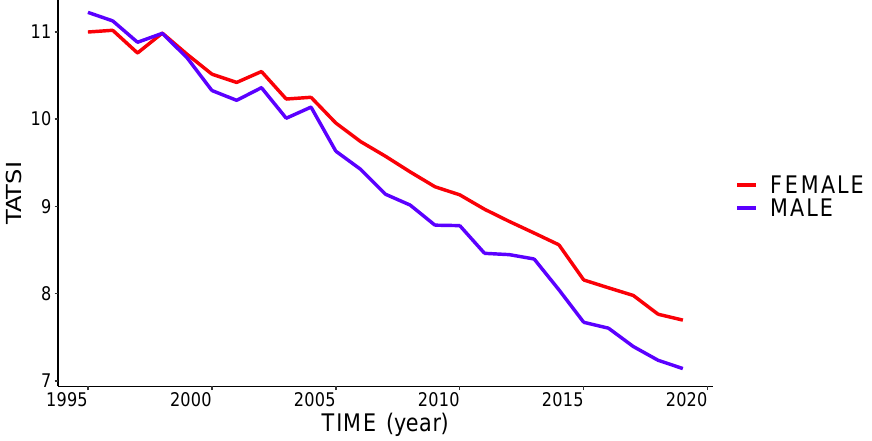
Figure 7. TATSI index for Italian female and male population aged 65 from 1995 to 2019. Source: author’s own elaboration on data from